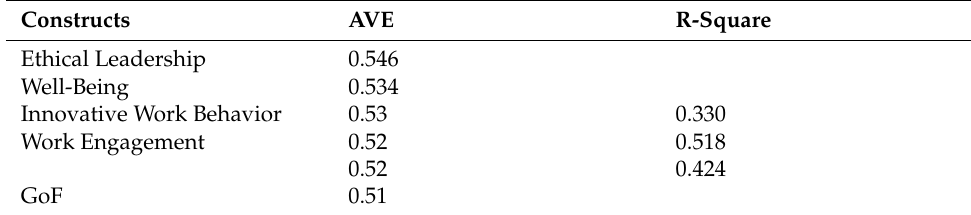
Table 5. The goodness of Fit